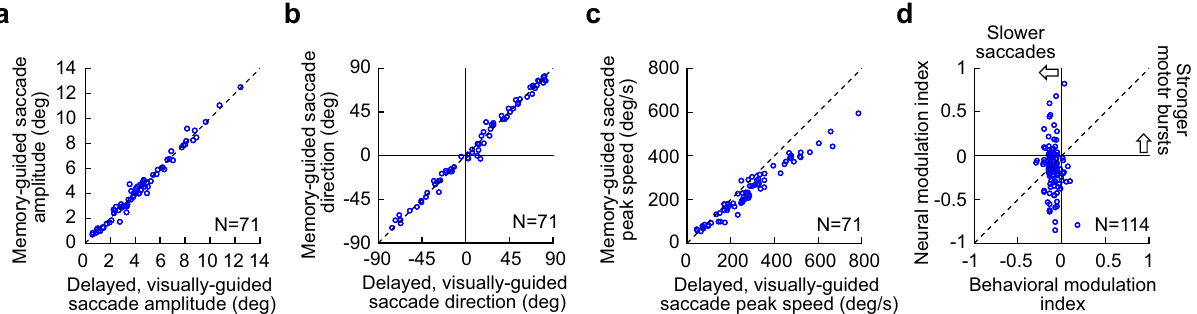
Fig. 8 Population summary demonstrating how SC motor burst strength is dissociated from saccade kinematics even for vector-matched movements. a Average saccade amplitude in the memory-guided saccade task versus the visually-guided saccade task across all unique sessions in this experiment. Each symbol indicates a single session. As per the experimental design, the saccade amplitudes were matched across the two conditions. b Same as a but for the directions of the saccades. Negative means downward saccades, and positive means upward saccades. Again, there was no difference in saccade angles across the visually-guided and memory-guided conditions. Thus, a and b indicate that the saccades in the two conditions were vector-matched. c Despite the vector matching, peak speeds were consistently lower for memory-guided saccades. d For all recorded neurons from the same sessions, we calculated a behavioral modulation index, in which negative values indicated slower saccades in the memory-guided condition. We also created a neural modulation index, in which negative values indicated weaker motor bursts in the memory-guided condition. Note that some neurons were recorded simultaneously during the same trials, as in Figs. 6, 7 ( “ Methods ” ). Thus, there were more neurons than sessions, explaining the different numbers of symbols in this panel relative to a – c ; this also meant that there could be multiple symbols with different y -axis values but having the same x -axis value (because multiple neurons were collected for the same behavioral trials). There was no correlation between neural and behavioral modulation